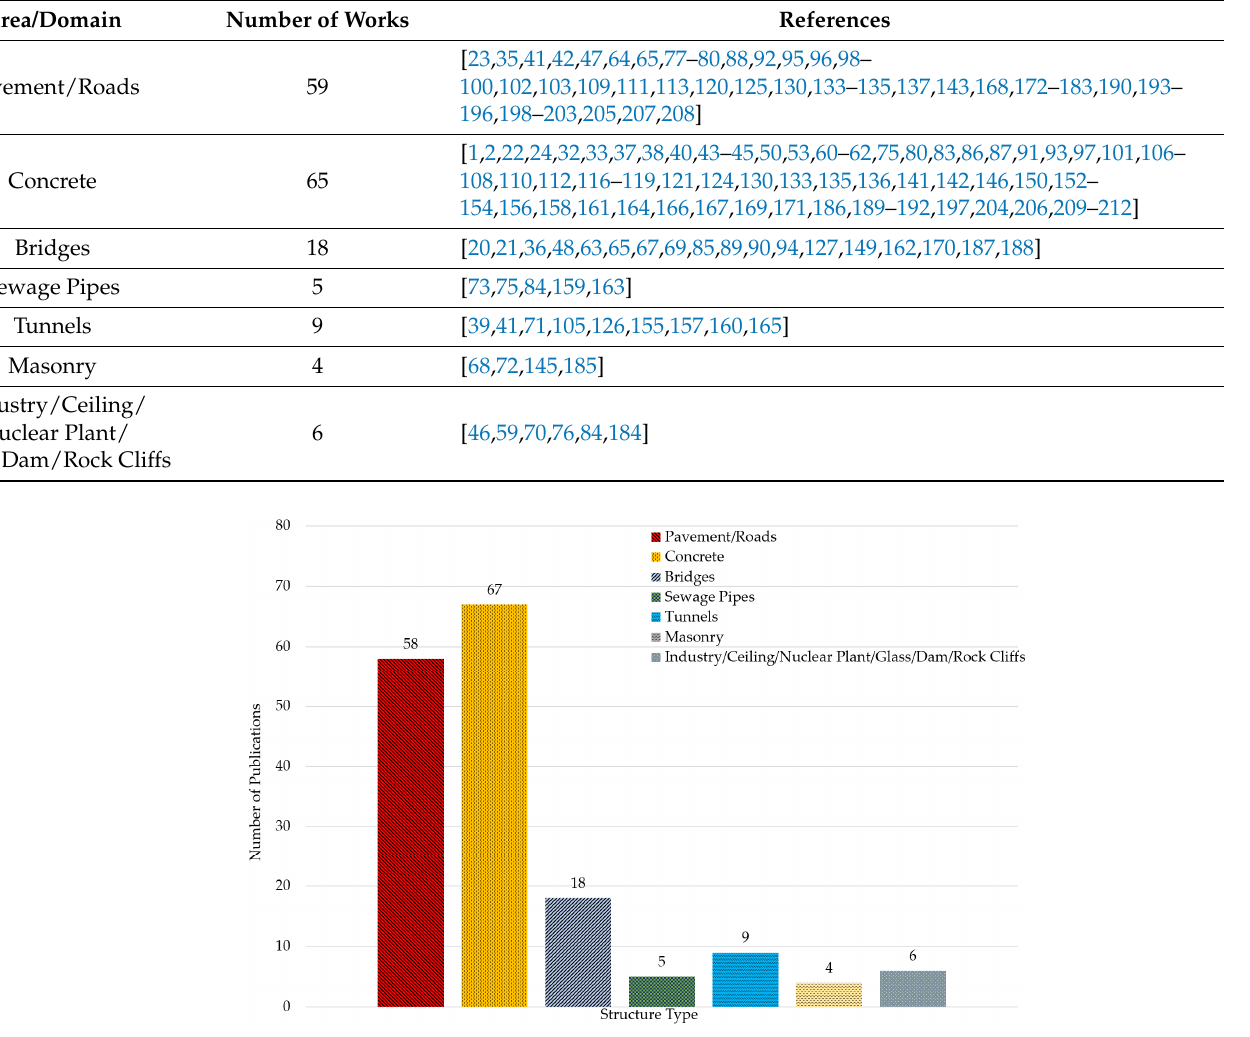
Table 11. Published articles on crack detection (domain wise).